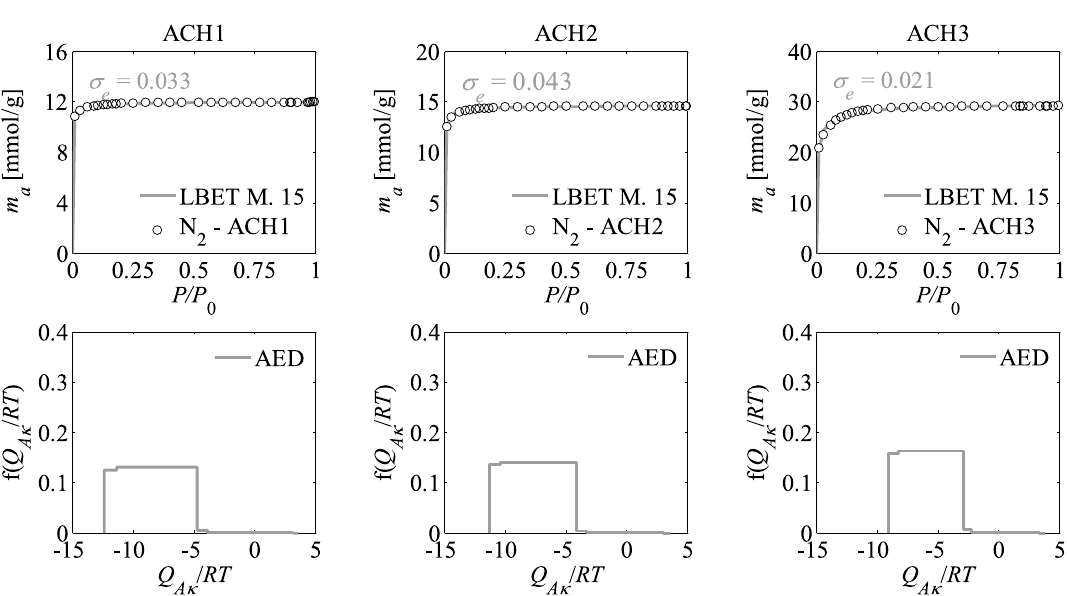
Figure 3. Nitrogen adsorption isotherms and adsorption energy distributions (AED) obtained by applying the LBET method to the experimental data for the activated carbons ACH R developed by chemical activation of Pine cones with KOH, at the highest temperature i.e. T = 1073 K with the different impregnations ratios ( R = 1, 2,